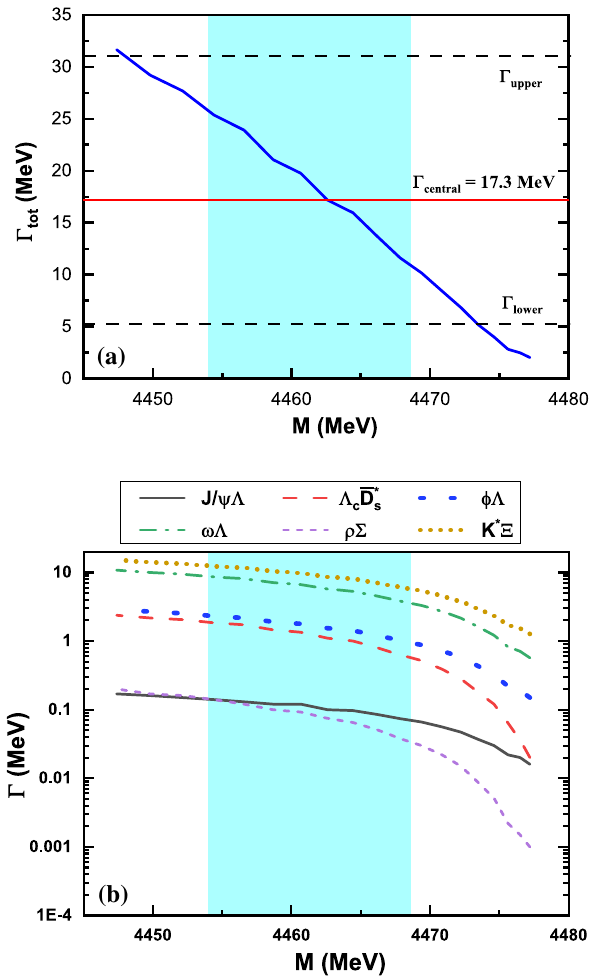
Fig. 4 The total ( a ) and partial ( b ) decay widths for the P cs ( 4459 ) as a coupled (cid:2) c ¯ D ∗ /(cid:2) ∗ c ¯ D /(cid:2) (cid:3) c ¯ D ∗ /(cid:2) ∗ c ¯ D ∗ molecule with I ( J P ) = 0 ( 3 / 2 − ) . The shallow area labels the position of the P cs ( 4459 ) including the experimental